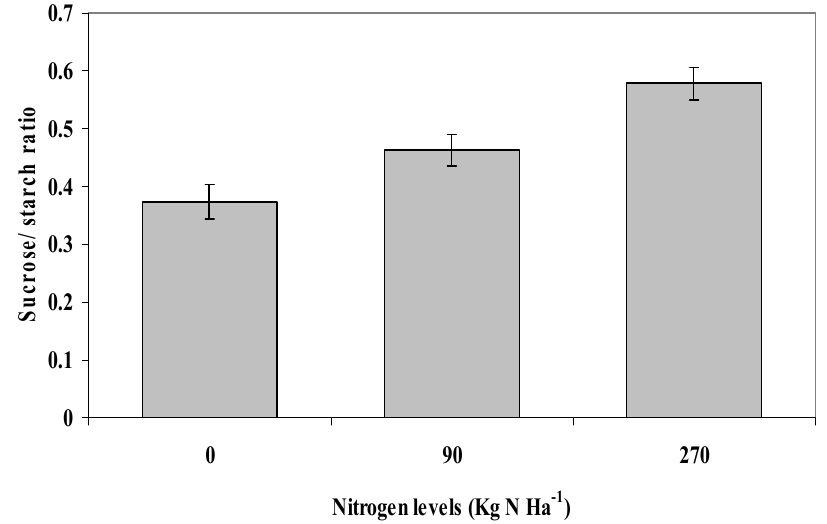
Figure 6. The effects of nitrogen levels on sucrose/starch ratio of L. pumila . N = 12. Bars represent standard error of differences between means